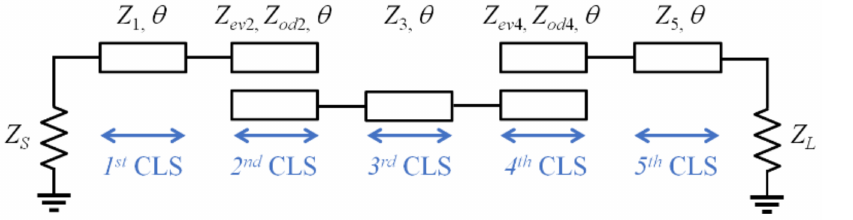
Figure 8. The topology of case 21 in category III.